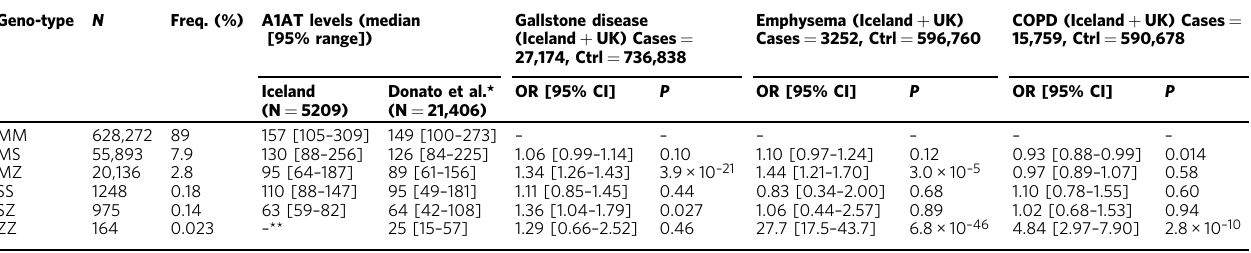
Table 2 Effect of alpha-1-antitrypsin genotypes on A1AT levels, gallstone disease, emphysema and COPD Geno-type N Freq. (%) A1AT levels (median Gallstone disease [95% range]) (Iceland + UK) Cases = 27,174, Ctrl =